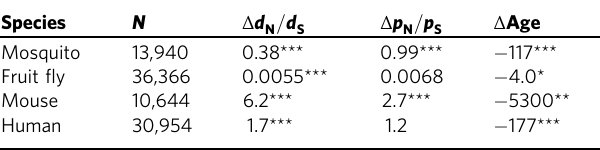
N is the number of pairs of paralogs compared. Entries in the table are the regressions of the difference in the statistic on the difference in REA for the pairs. Signi fi cance was determined using the Spearman rank correlations (two-sided tests, not corrected for multiple tests). Exact p values are given in Supplementary Table